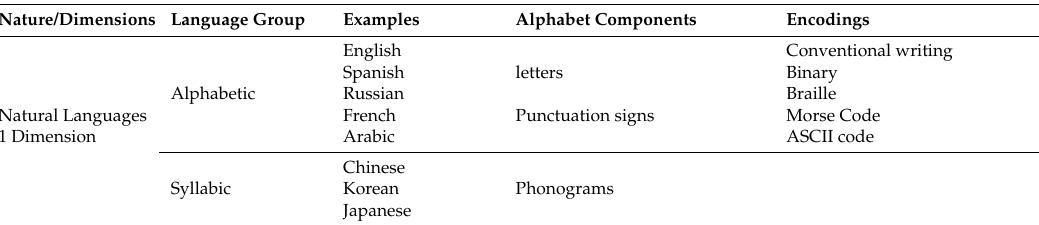
Table 1. Examples of Languages of different nature and their corresponding writing and encoding systems. Nature/Dimensions Language